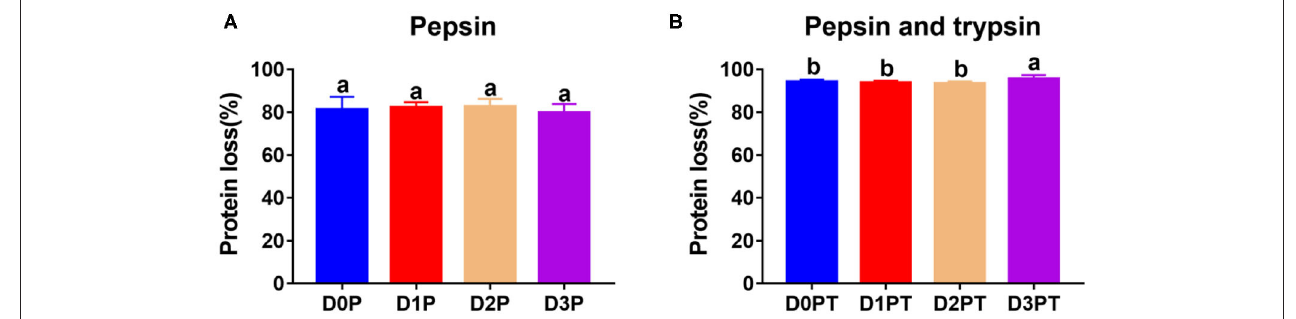
FIGURE 2 | Protein digestibility did not differ after pepsin treatment by differ significantly after pepsin and trypsin treatments. (A) D0P, D1P, D2P, and D3P represent 0, 1, 2, and 3 d samples treated by pepsin, respectively. No significant difference was observed among groups ( P > 0.05). (B) D0P/T, D1P/T, D2P/T, and D3P/T represent 0, 1, 2, and 3 d samples treated by pepsin and trypsin, respectively. a, b denotes that protein digestibility differ significantly ( P < 0.05, n = 8 each).